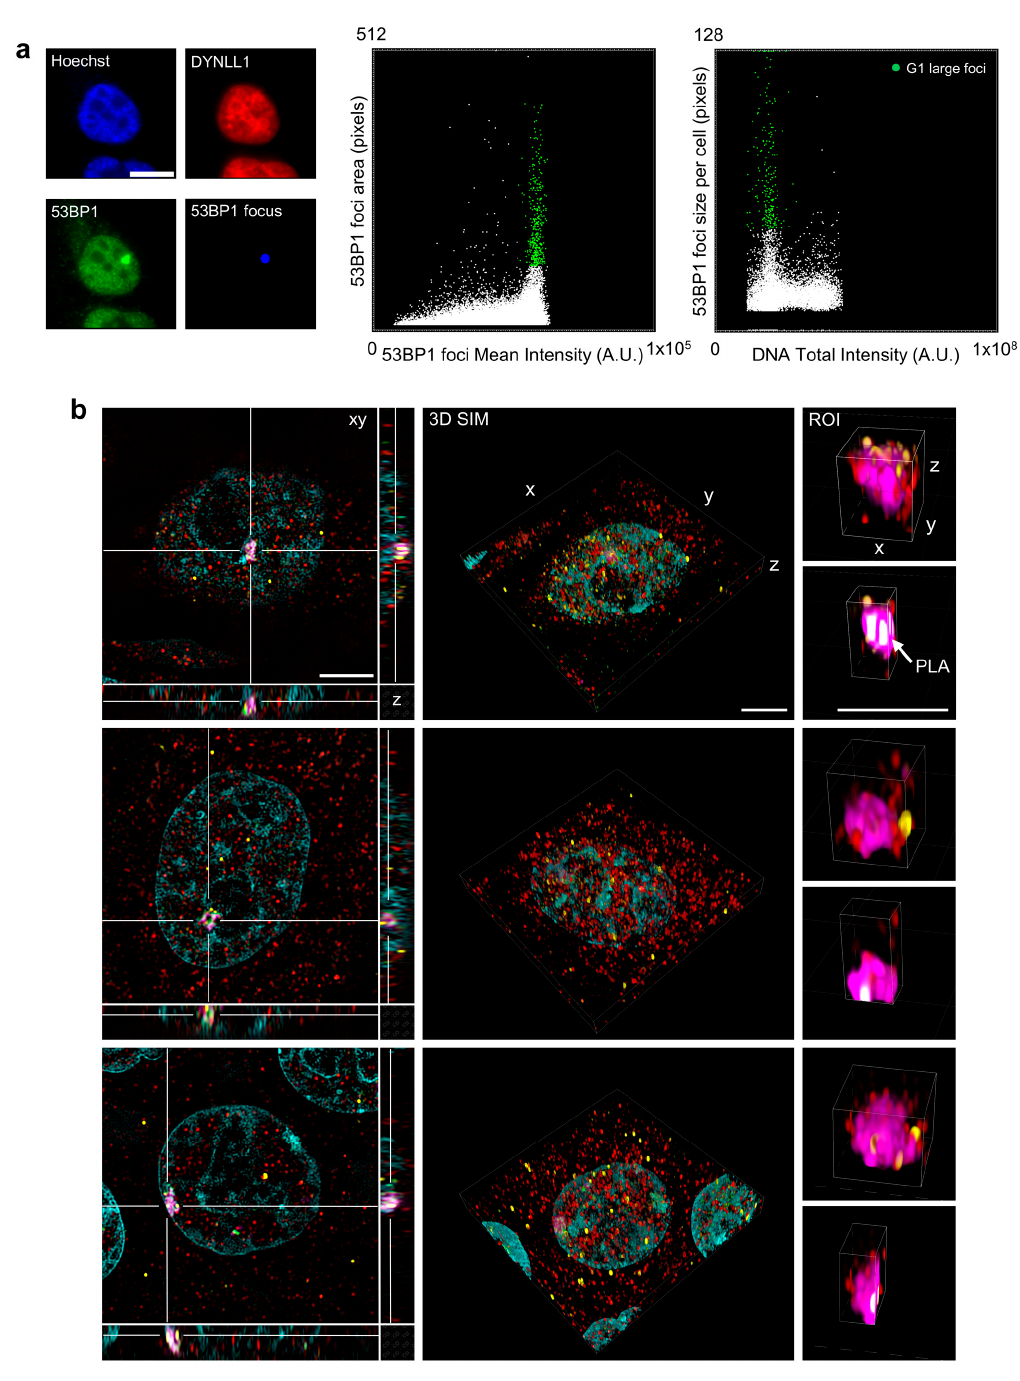
Figure 5. 53BP1 large foci targeted by Image-Cytometry Analysis. ( a ) 53BP1 shows accumulation in large foci that can be identified by high mean intensity and area when considering the distribution of the spots independently from the cell of origin (dot plot in the middle column). When reassigned to the originating cells, the targeted cell population localizes in the G1 phase of the cell cycle (dot plot on the right) identified also by the high average size of the 53BP1 foci. ( b ) Lateral-plane reconstruction (first column) and 3D volume projections of cells (second column) and large 53BP1 foci (third column) of representative events from the previously isolated group re-localized by the Image-Cytometry Analysis and acquired by Structured Illumination Microscopy (SIM). 53BP1: Magenta; DYNLL1: Red; PLA: Yellow; DNA: Cyan. Scale bar: 5 µ